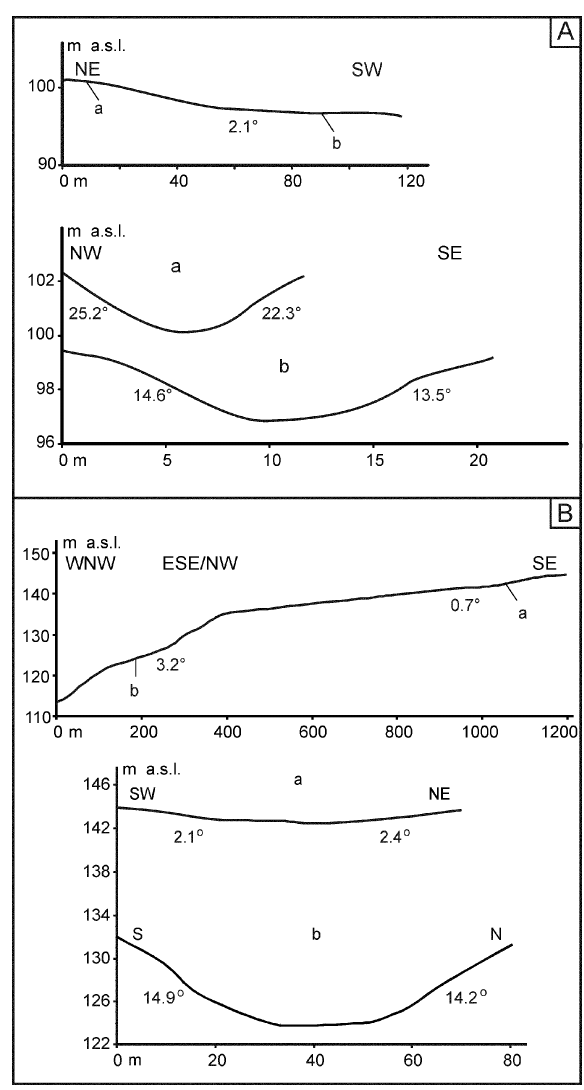
Fig. 2. Morphological profiles of example valleys: A, upper and middle parts of the P1 valley; B, upper and lower parts of the J3